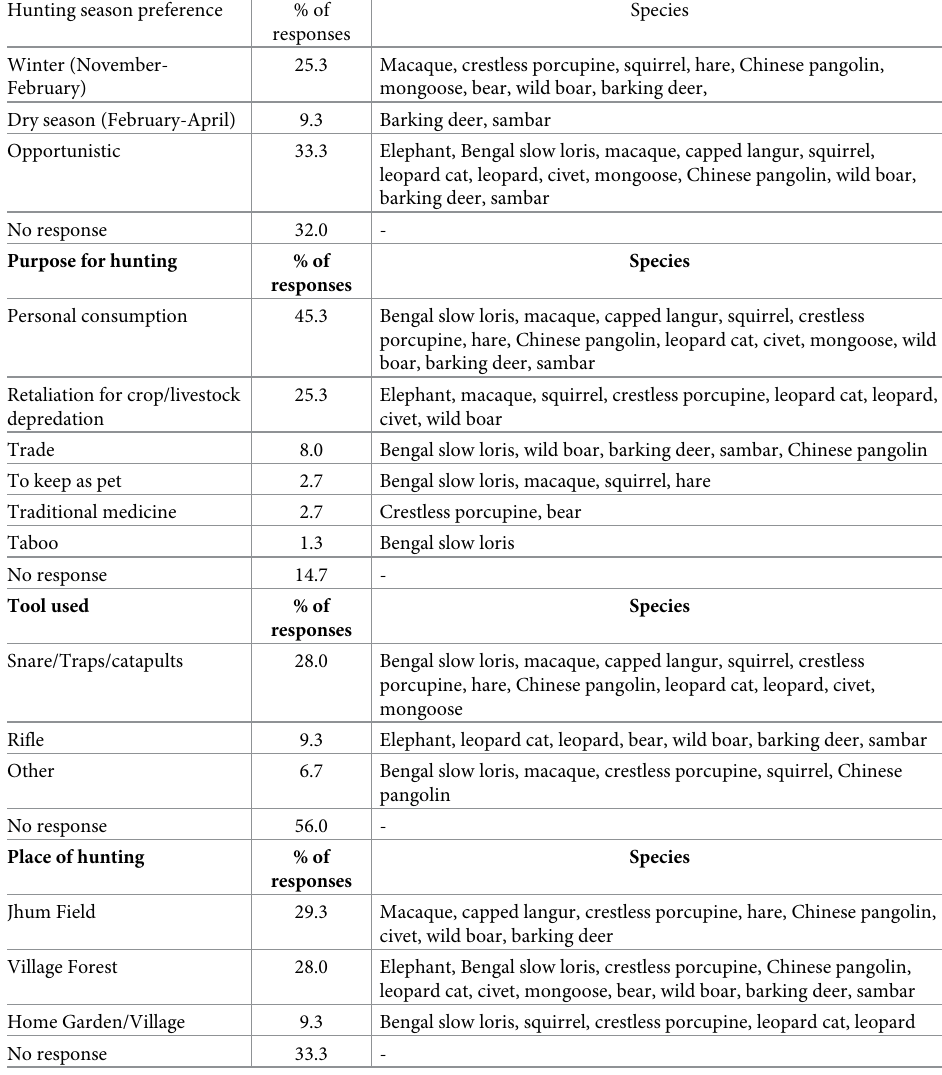
Table 2. Purpose of hunting by locals, tools used, place of hunting and season preference (n =